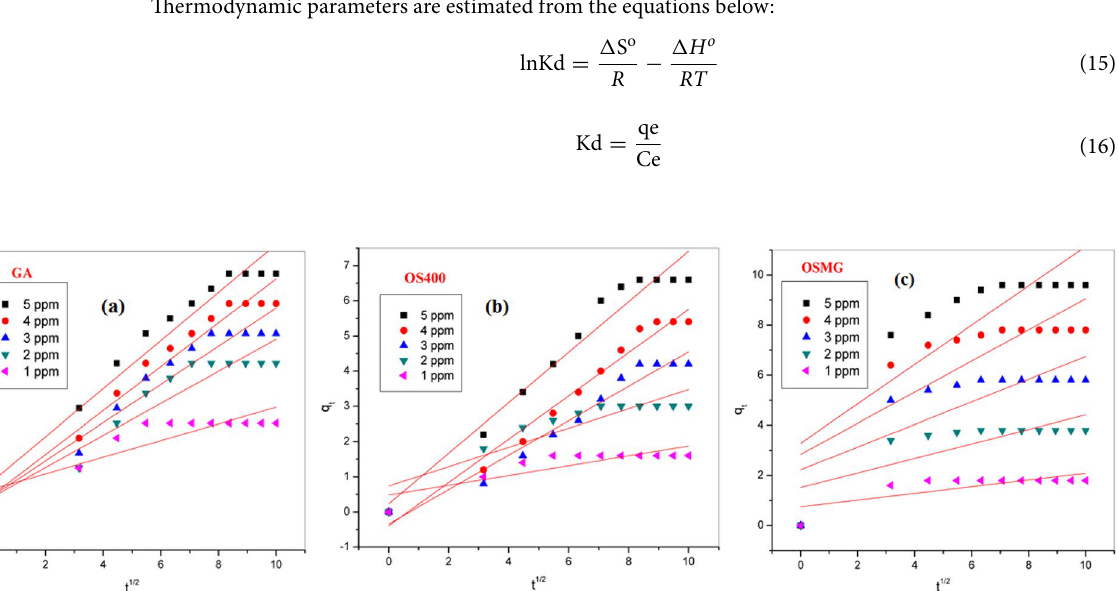
Figure 13. Weber-Morris Intraparticle diffusion model for the adsorption of MB onto ( a ) GA, ( b ) OS400 and ( c ) OSMG.